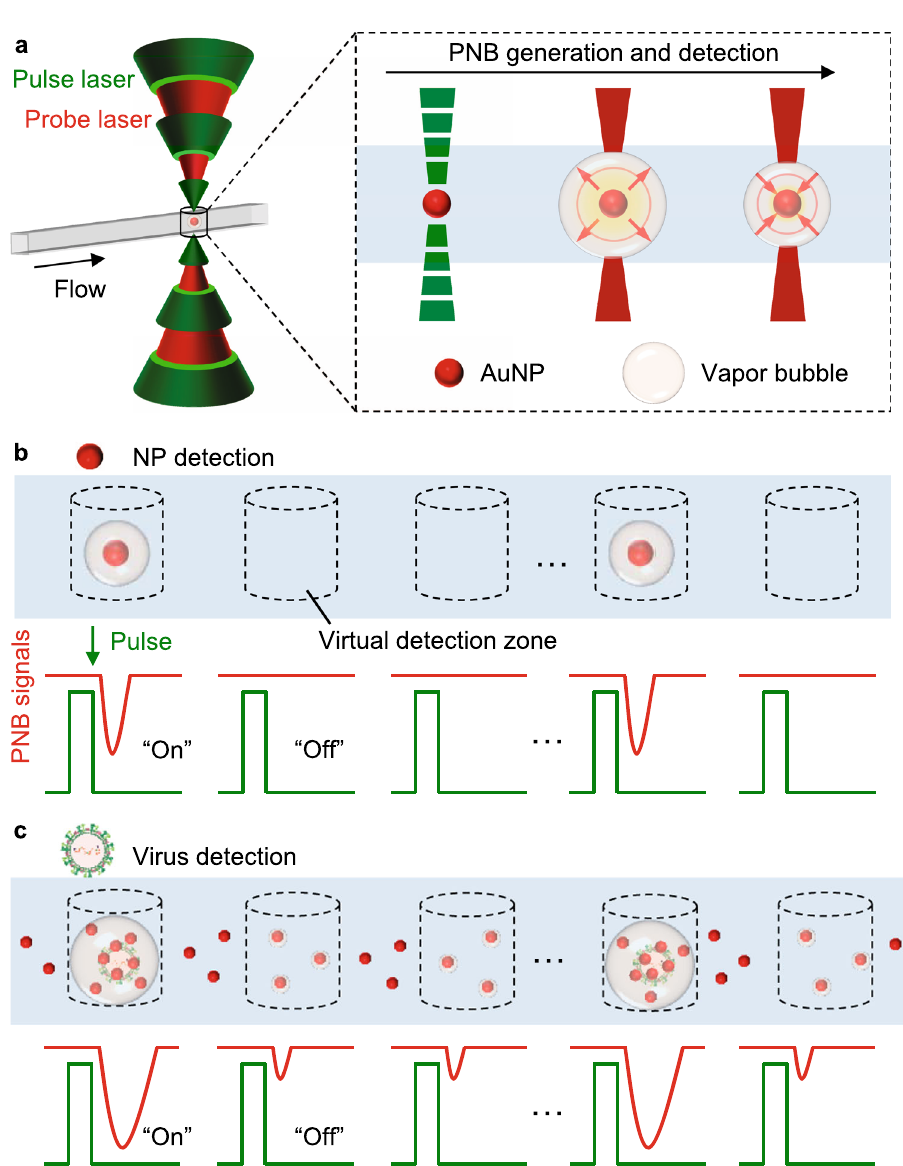
Fig. 1 Concept of DIgitAl plasMONic nanobubble Detection (DIAMOND). a The schematic illustration of the plasmonic nanobubbles (PNBs) generation and detection in fl ow. The gold nanoparticles (AuNPs) as labels are used for the generation of the PNBs by short laser pulses and subsequently detected by a secondary probe laser due to the ampli fi ed optical absorption. b , c The principle of digital counting for NP ( b ) and virus ( c ) detection. The “ on ” and “ off ” in ( b ) and ( c ) refer to the positive and negative PNB signals representing for the presence or absence of targets (i.e., NP and virus, respectively). The laser pulses create “ virtual ” detection zones as compartmentations for independent counting of PNB signals. The three dots shown in ( b ) and ( c ) refer to ellipses and indicate the omission of detection events in a repeated